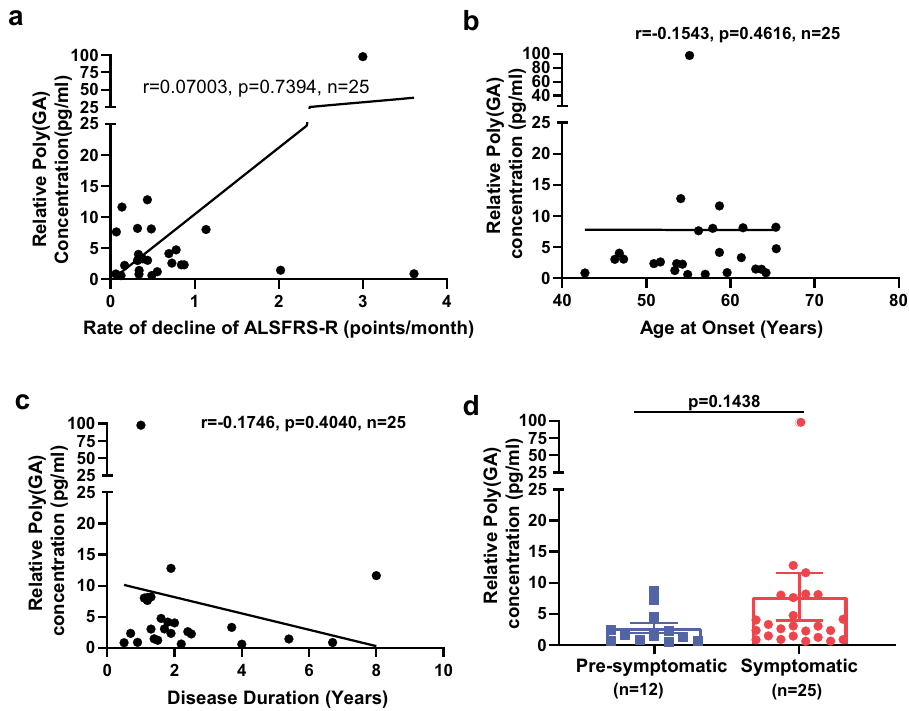
Fig. 3 Poly(GA) levels in CSF do not correlate with clinical features of patients with C9ORF72 mutations. a – c Correlation between poly(GA) levels and the rate of ALSFRS-R score decline ( a ), age at disease onset ( b ), and disease duration ( c ), determined by two-tailed Spearman ’ s rank-correlation analysis. d Poly(GA) levels in CSF from symptomatic and asymptomatic patients with C9ORF72 mutations are similar by two-tailed unpaired t -test with Mann – Whitney test. Poly(GA) concentrations are presented as values equivalent to (GA) 60 and not as an absolute poly(GA) concentration since the size of poly(GA) in CSF is unknown. The samples assessed in Figs. 2, 3 are overlapping but not identical and include 17 samples for which both poly(GA) and poly(GR) were detected. Source data are provided as a Source Data fi